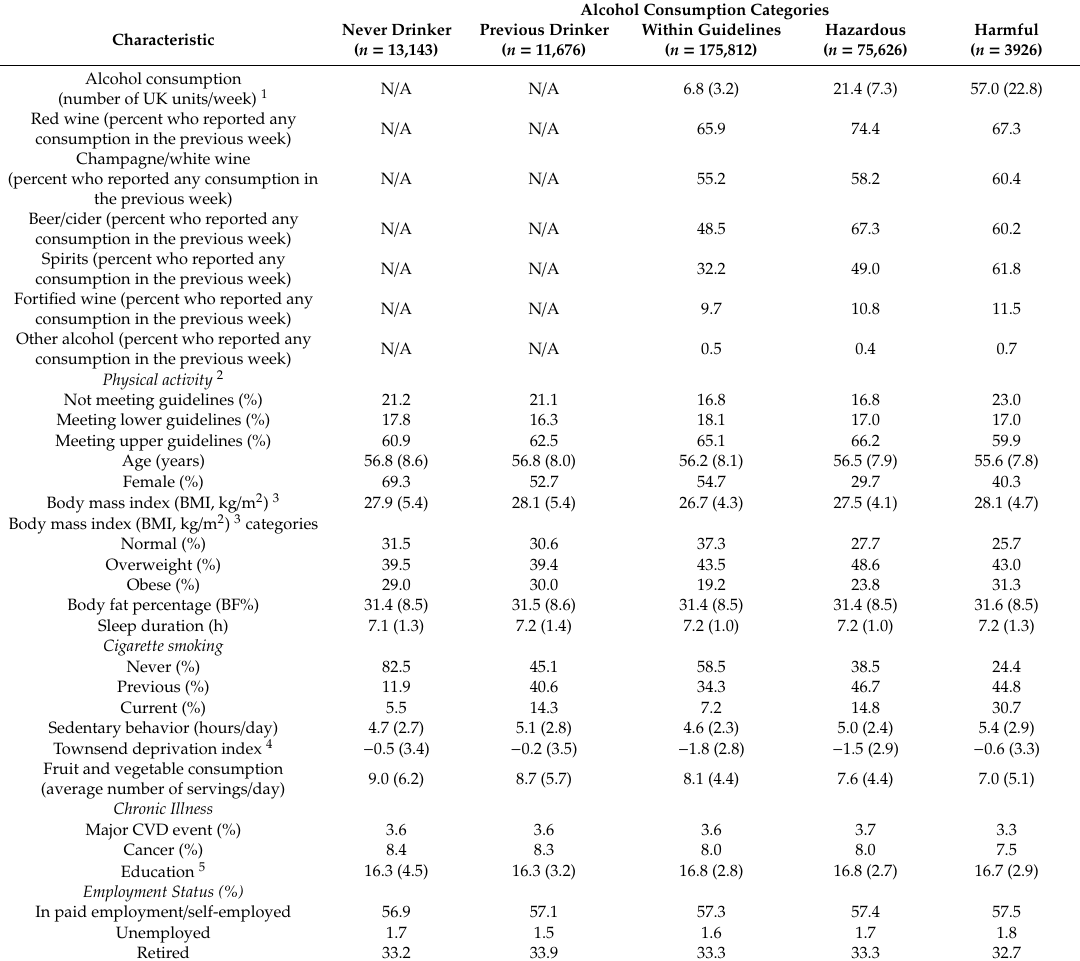
Table 1. Characteristics of study sample by level of alcohol consumption ( n =